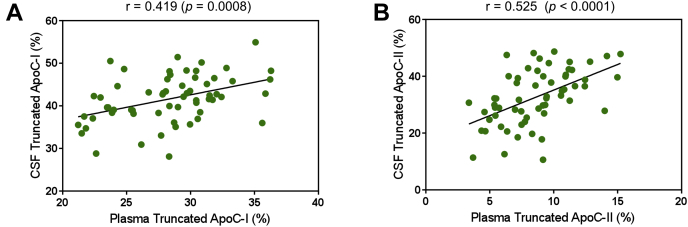
Correlation between (A) truncated apoC-I and (B) truncated apoC-II in the paired plasma and CSF samples. Shown are the parametric Pearson's correlation coefficients.